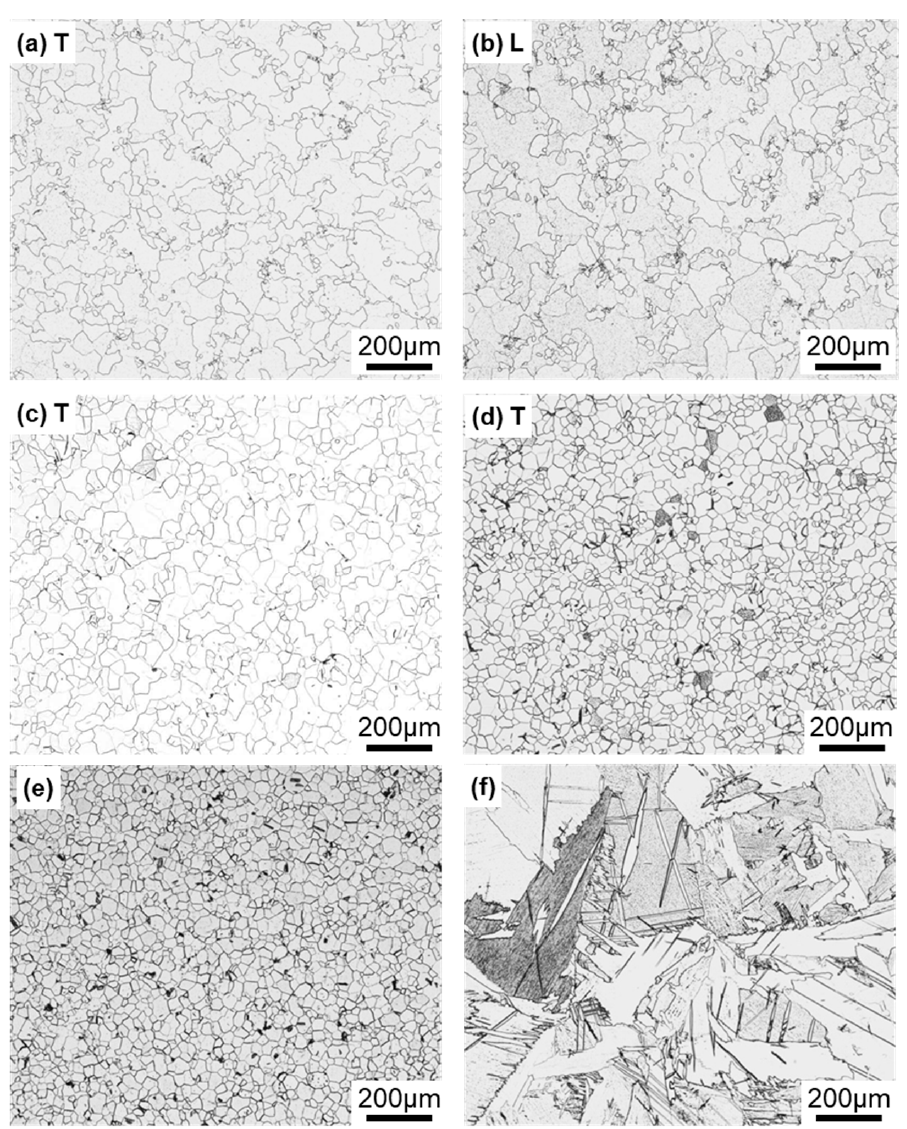
Figure 4. Optical microscopy images of ( a , b ) 10-times-laser-sintered EOS CP Ti G 2 and ( c , d ) once-sintered TILOP CP Ti G 2 built in ( a , b , c ) 90° and ( d ) 0° directions; ( a , c , d ) transverse (T) sections to the building direction and ( b ) longitudinal (L) section perpendicular to the building direction; ( e , f ) optical microscopy images of wrought and dental-cast (center part) CP Ti G 2 rods, respectively.